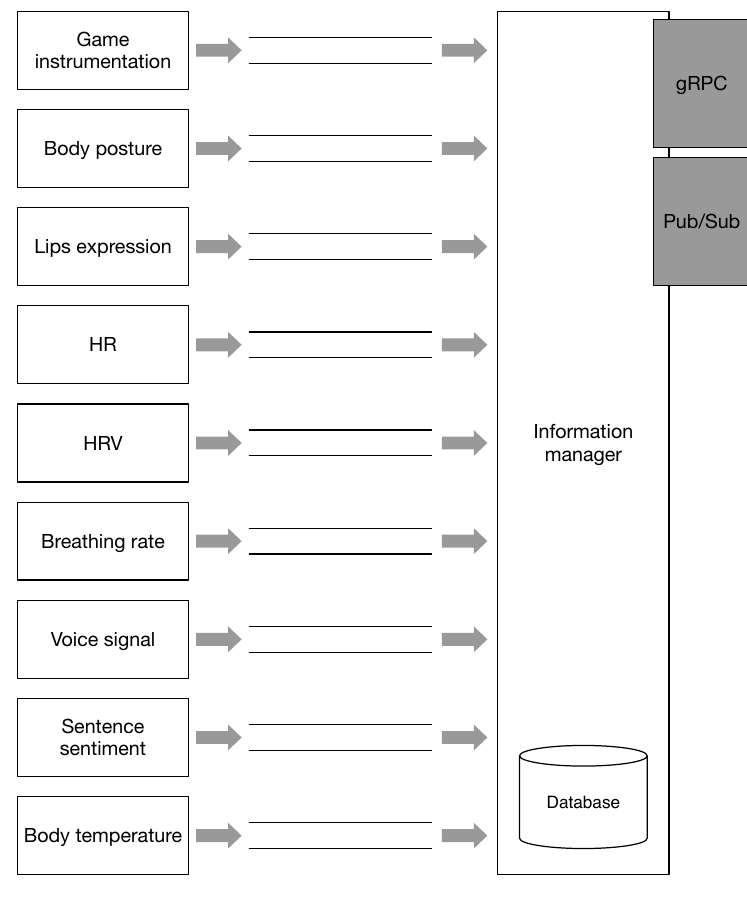
Figure 3. Sensor